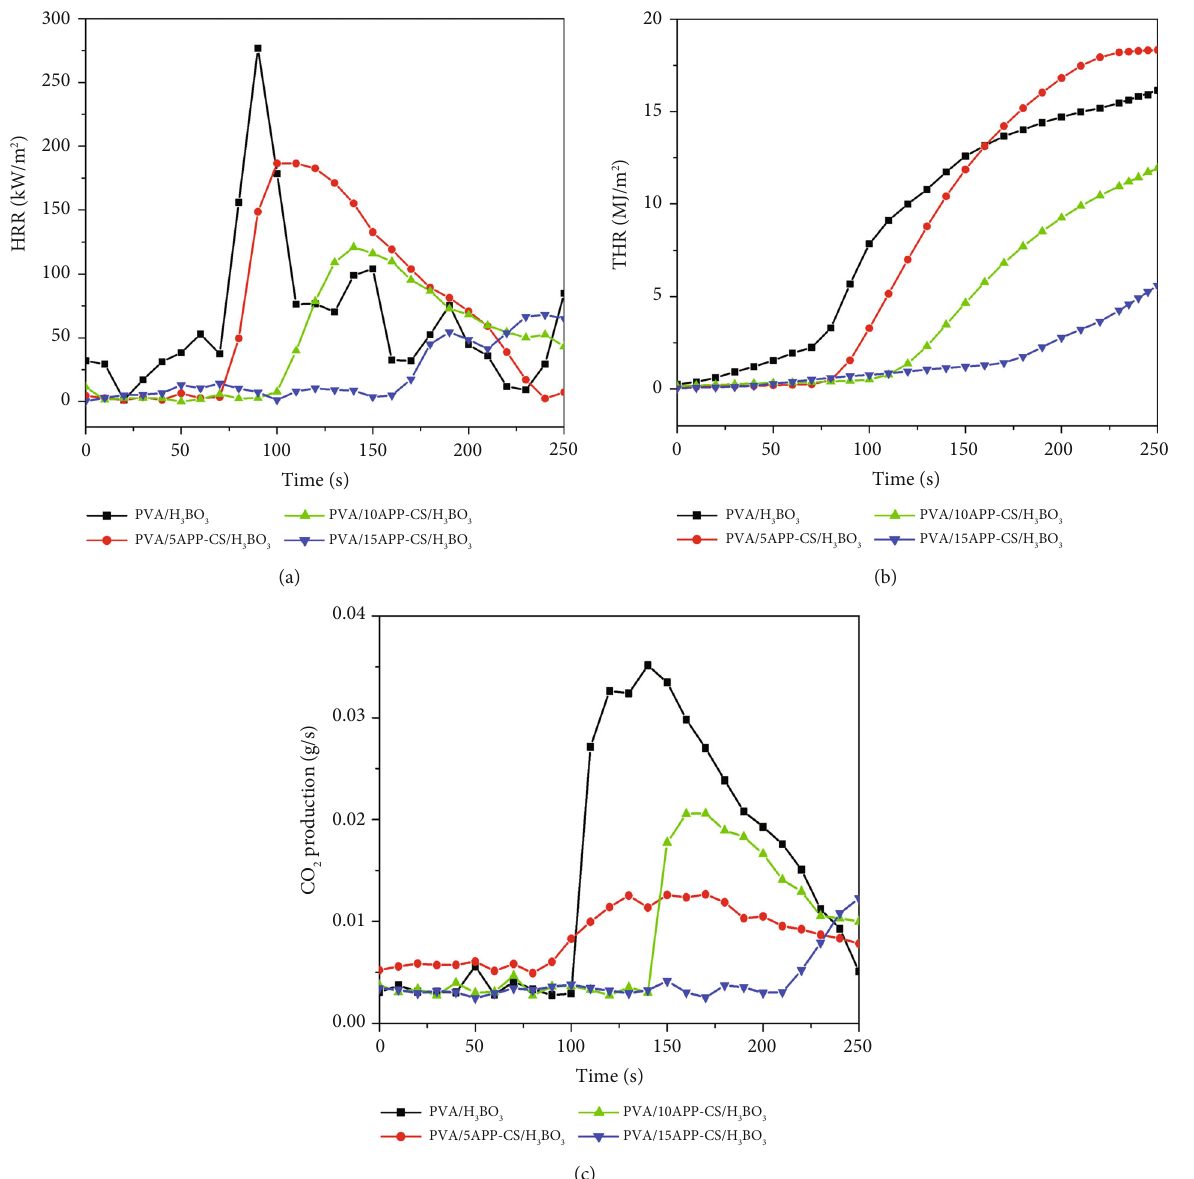
production curves of the PVA composite 2